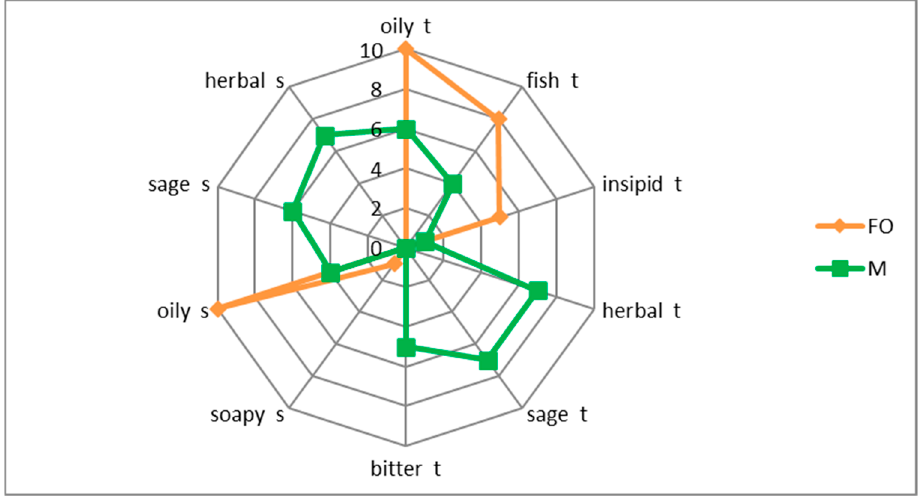
Figure 3. Taste (t) and odor (s) profile macerate (M, green) compared to pure cod liver oil (FO, or- ange).